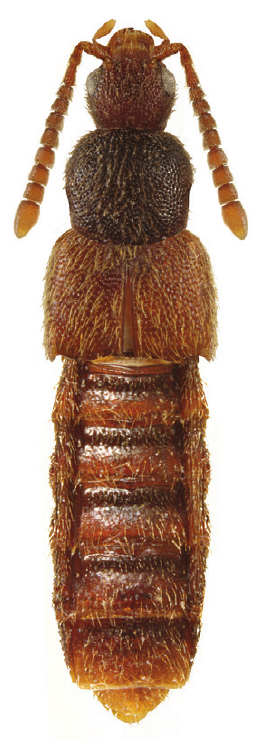
Fig. 2. Dorsal habitus photograph of Ilyobates bennetti (from Gouix and Kli- maszewski